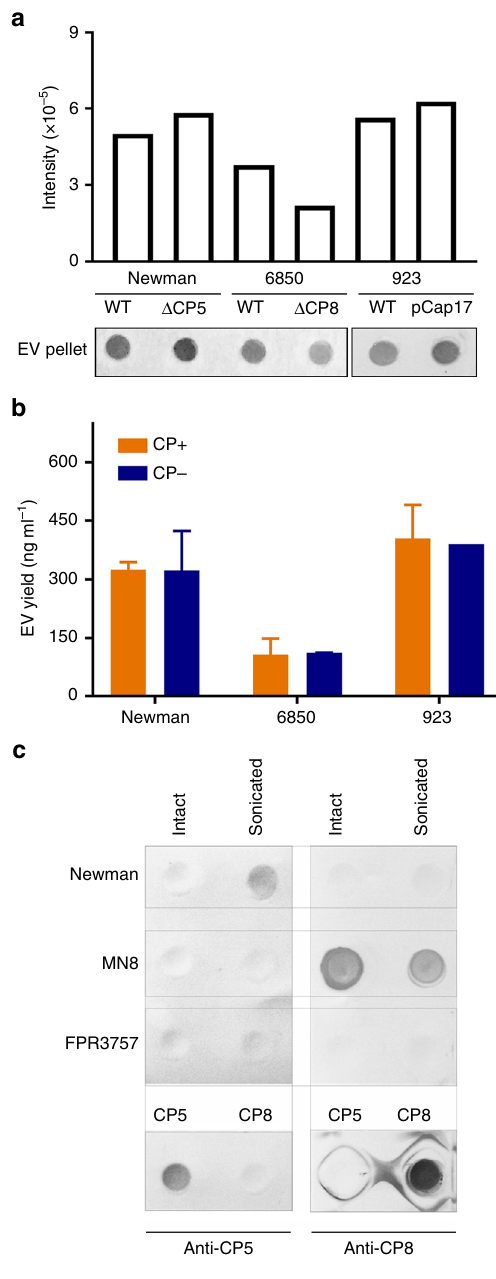
Fig. 5 Effects of S. aureus capsular polysaccharide synthesis on EV production. a EV production from encapsulated S. aureus (Newman, 6850, 923 [pCP5]) or their CP-negative counterparts (Newman Δ cap5O , 6850 Δ capHIJK , and 923) was evaluated by dot-blotting EV suspensions or b by quanti fi cation of total EV protein yield. c CP5 or CP8 was detected in intact or sonicated EVs (35 µ g) from strains Newman, MN8, or FPR3757 by immunoblots probed with 1.2 µ g ml − 1 CP5-speci fi c mAb 4C2 or CP8- speci fi c mAb 5A6. Controls included 15 µ g puri fi ed CP5 and CP8. The dot immunoblot assay was repeated at least twice with similar results; a representative blot is shown. EV protein yields were calculated from at least three independent experiments and expressed as mean ±